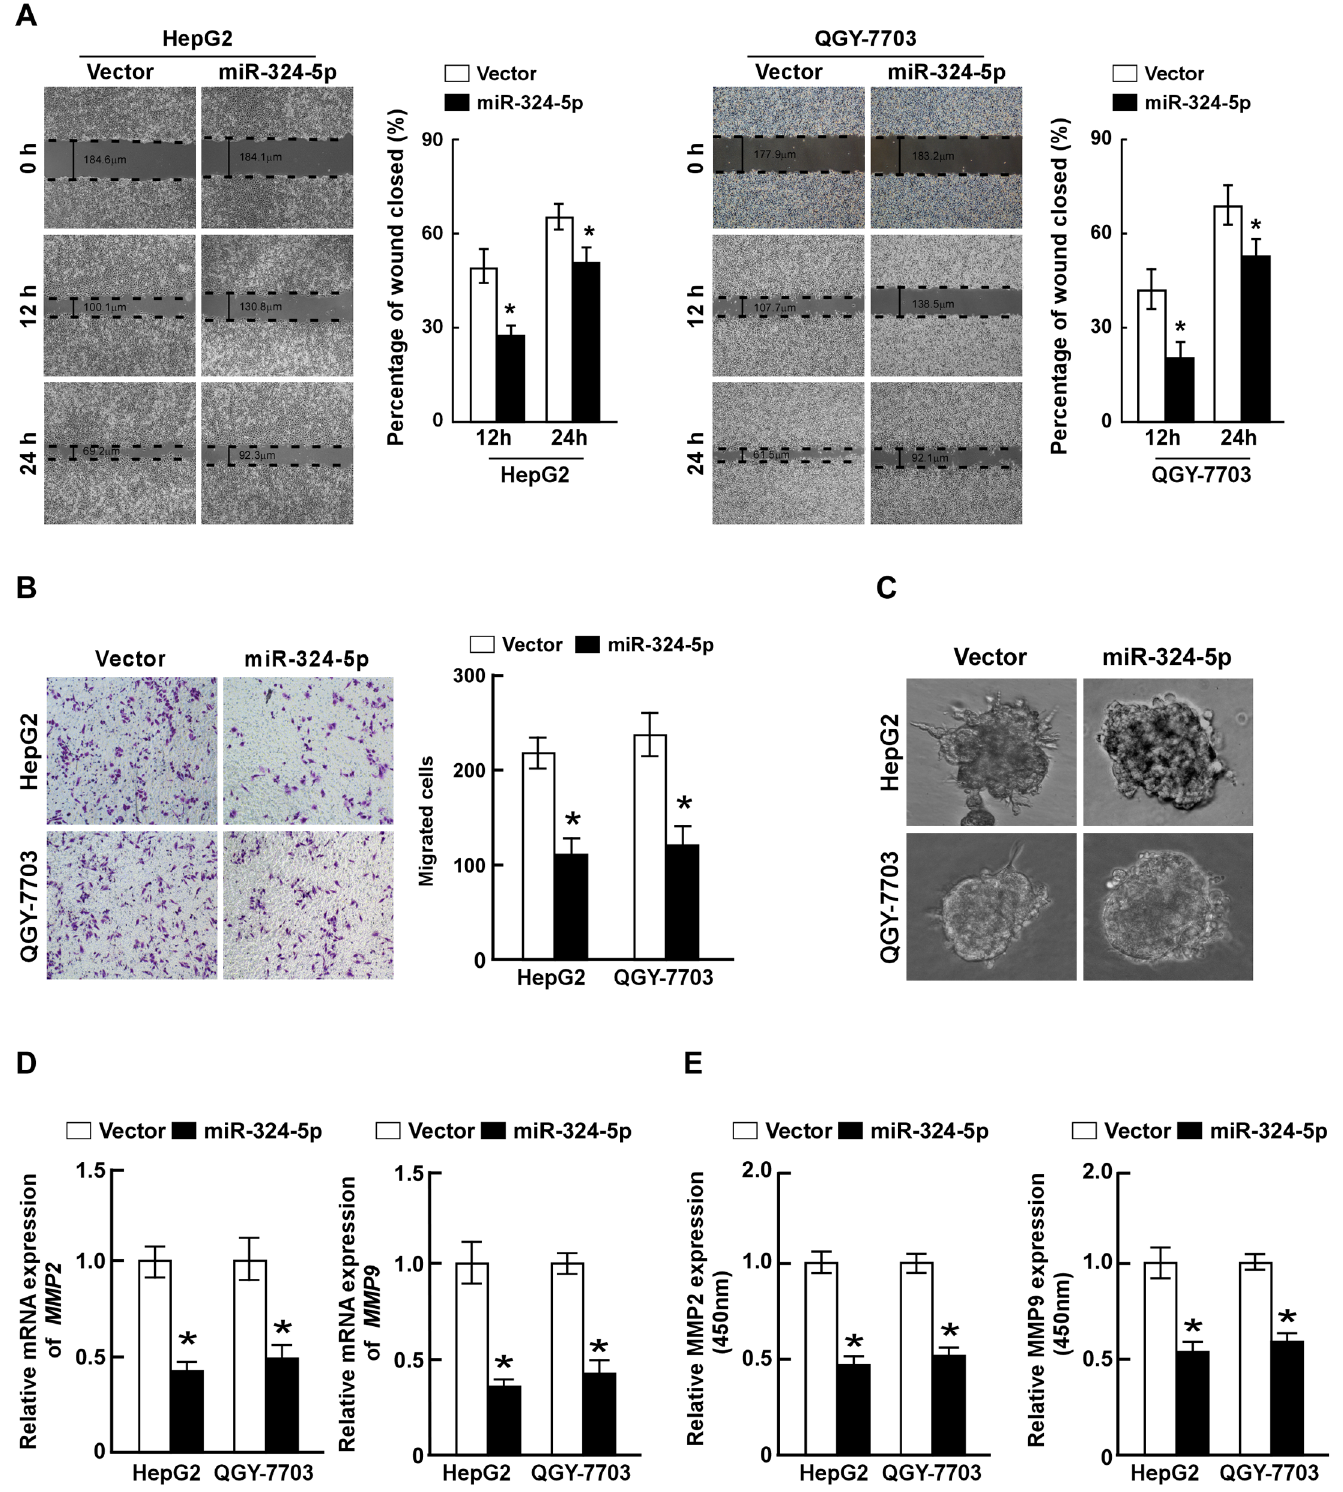
Fig 2. Ectopic expression of miR-324-5p inhibits HCC cells migration and invasion. A. Representative micrographs (left) and quantifications (right) of wound healing assay of the indicated cells. Wound closures were photographed at 0, 12 and 24 hours after wounding. B. Representative micrographs (left) and quantifications (right) of indicated invading cells in a Matrigel-coated Transwell assay. C. Representative micrographs of indicated cells grown on Matrigel for 10 days in 3-Dimensional Cell Culture. D. Real-time PCR analysis of MMP2 and MMP9 expression in indicated cells. GAPDH served as control. E. The activity of MMP2 and MMP9 in indicated cells determined by ELISA assay. Each bar represents the mean ± SD of three independent experiments. * P < 0.05. doi:10.1371/journal.pone.0133074.g002 PLOS ONE | DOI:10.1371/journal.pone.0133074 July 15,